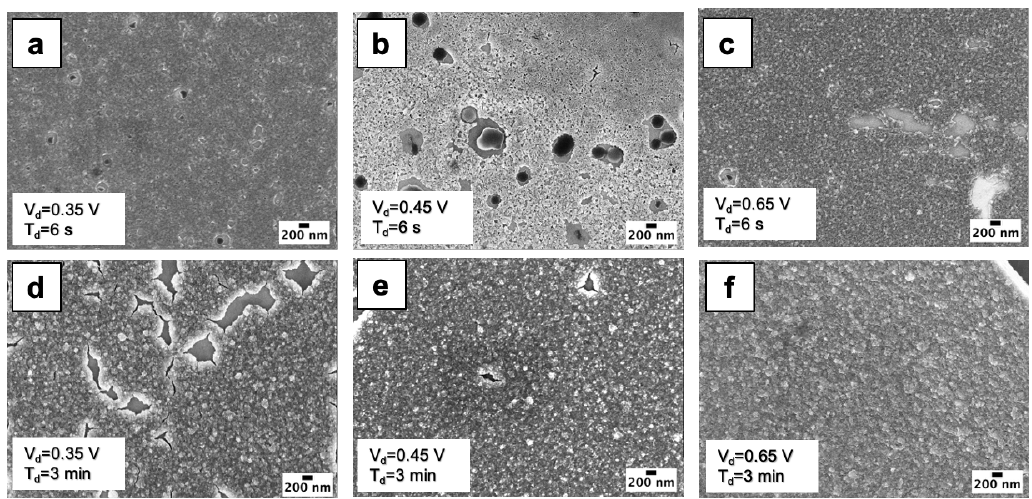
Figure 2. SEM images of electrodeposited WO 3 by using: ( a ) V d = 0.35 V and t d = 6 s; ( b ) V d = 0.45 V and t d = 6 s; ( c ) V d = 0.65 V and t d = 6 s; ( d ) V d = 0.35 V and t d = 3 min; ( e ) V d = 0.45 V and t d = 3 min;